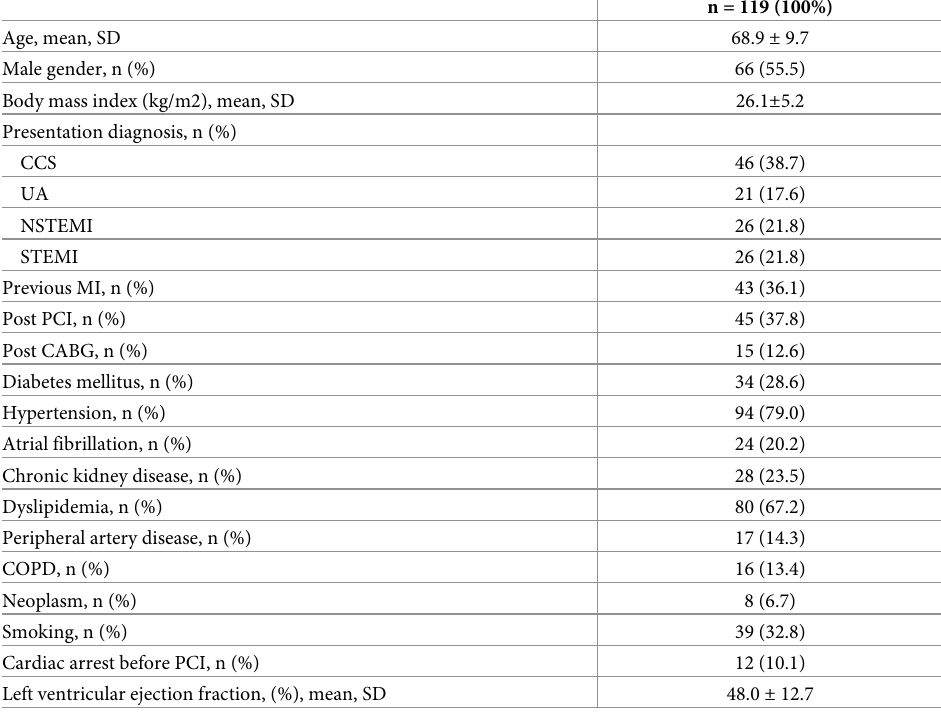
Table 1. The baseline clinical characteristics of the patients.